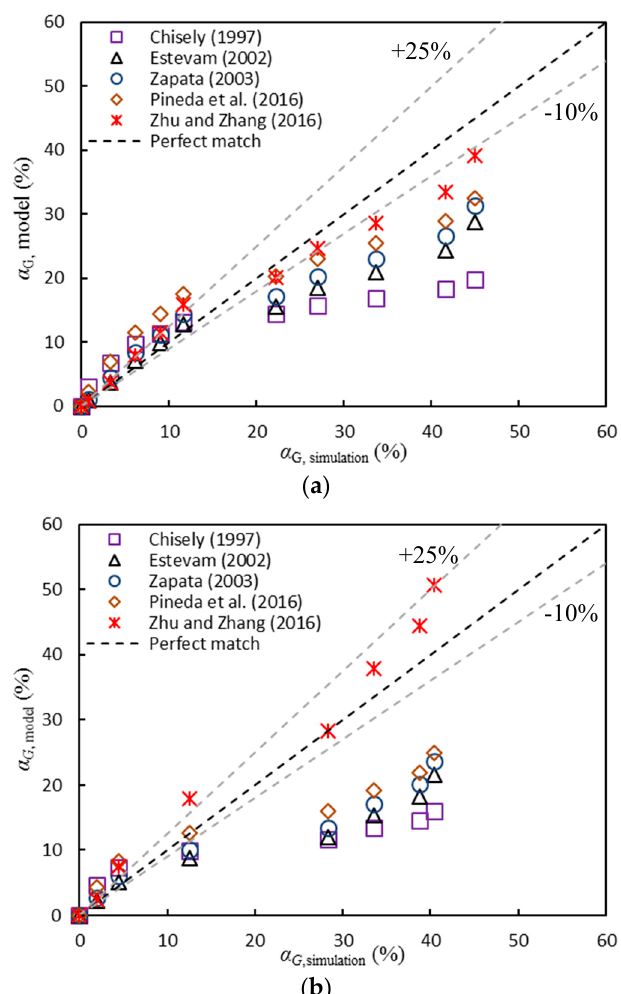
Figure 22. Comparison of model predictions of in-situ gas void fraction against CFD simulation results [90], ( a ) N = 3500 rpm; ( b ) N = 1800 rpm.